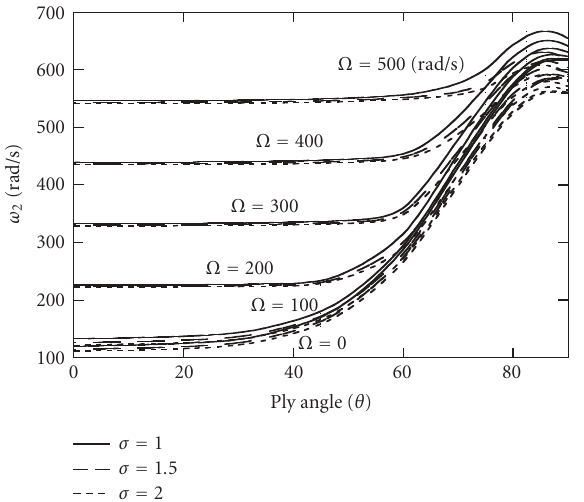
Figure 7: Variation of the first coupled frequency versus pretwisted angle for selected rotational speeds with two di ff erent taper ratios ( θ = 90 deg).